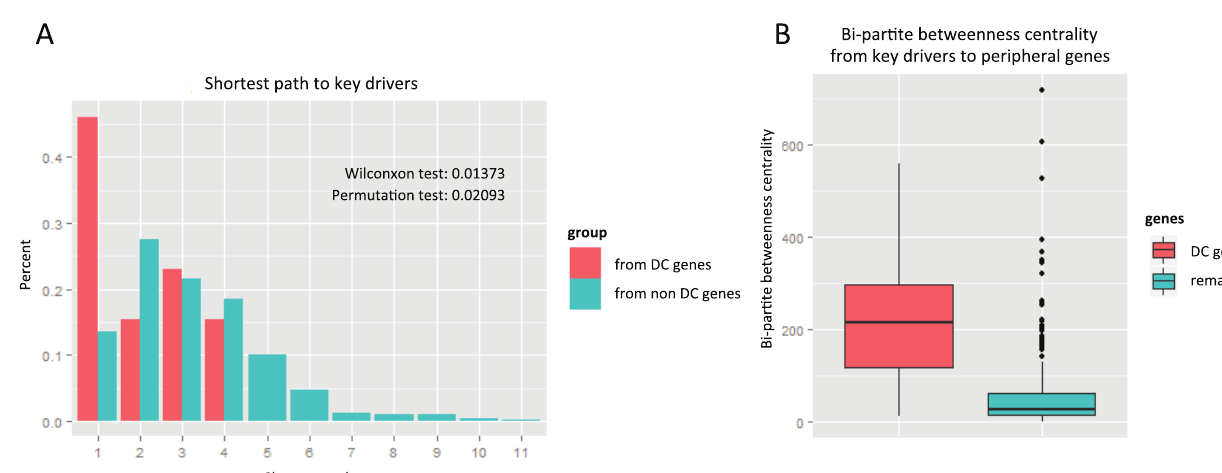
Figure 4. Topological properties of Differentially Correlated Genes (DCGs). A ) Barplot of the shortest path to the causal genes and originated in either the genes in DCPs (in orange) or the non DCP genes (in blue). The distribution in orange is concentrated in lower values. B ) Boxplot comparing the values of Bipartite Betweenness Centrality of the genes in DCPs (in orange) and the non-DCP genes (in blue). The boxplot on the left is concentrated in higher values.